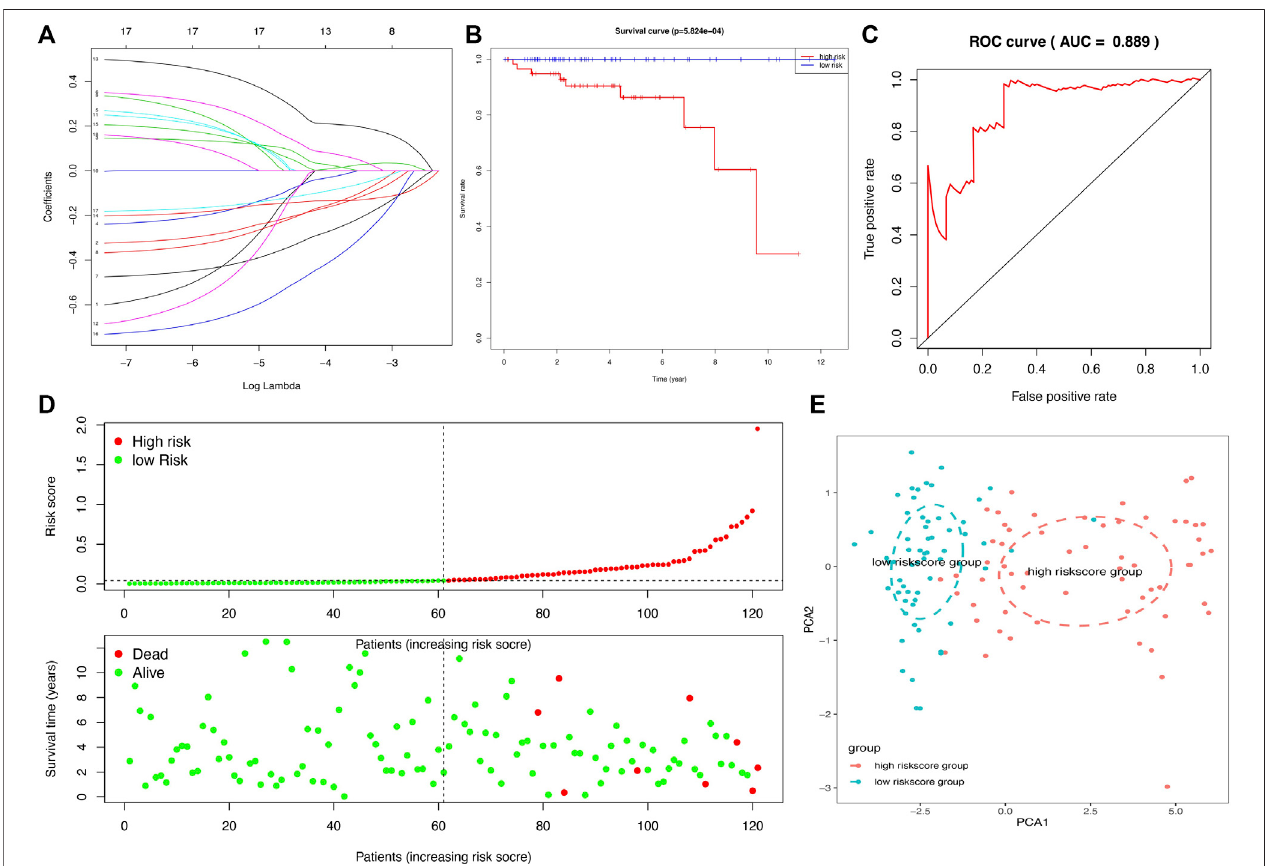
FIGURE6| Alasso regressionidenti fi ed theprognostic modelin THYM. (A) Lassoregressioncomplexitywasevaluatedusing lambda. (B) Overallsurvivalanalysis between high- and low-risk score groups from the 11-gene prognostic model in THYM. (C) ROC curve based on risk score in THYM. (D) The distribution of survival status (dead or alive) between high- and low-risk score groups in THYM. (E) PCA plot based on risk score in THYM.